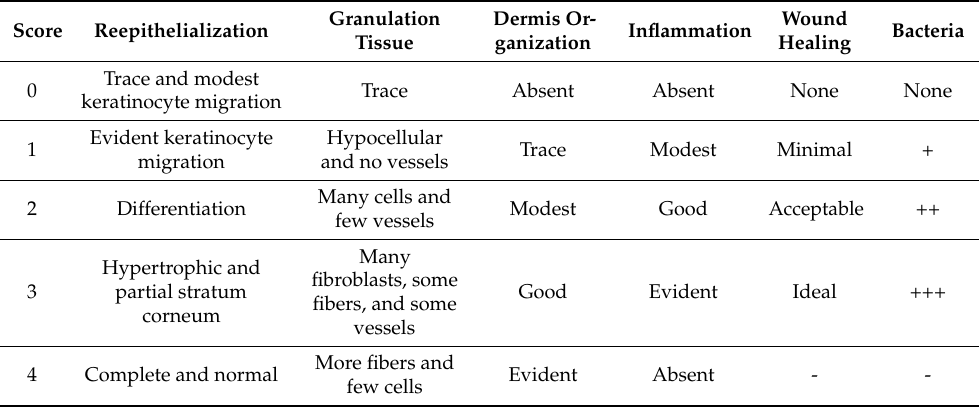
Table 2. Histologic evaluation of morphological changes and wound healing. (Adapted by Simonetti et al. [15] and Lazarus et al.